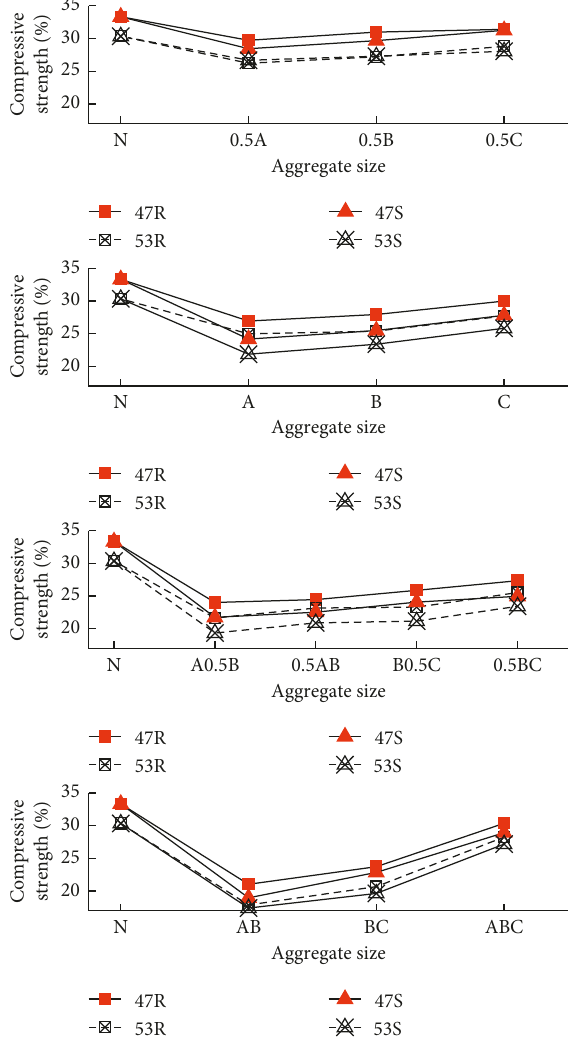
Figure 6: Relationship between the compressive strength and size of recycled aggregate at the same recycled aggregate content of 0%, 16.7%, 33.3%, 50%, 66.7%, and